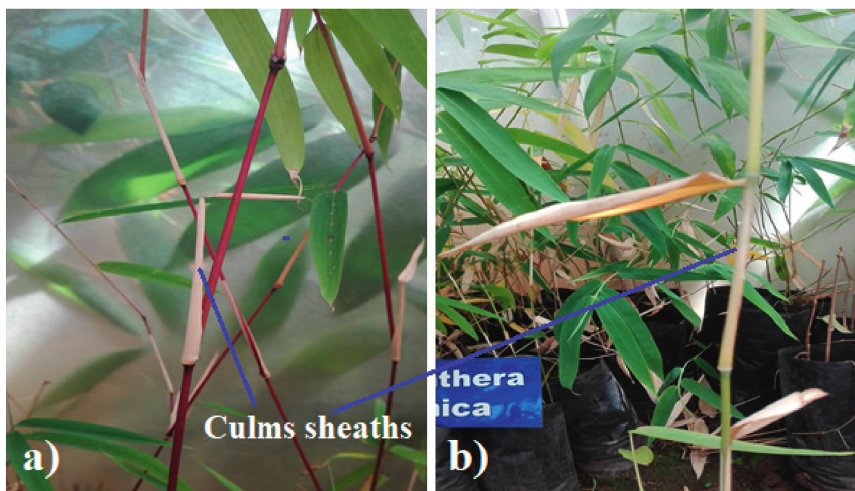
Figure 4: Culms sheaths of (a) O. alpina and (b) O. abyssinica . Leaves: linear lanceolate-shaped leaf blade is extended from the culm sheath.